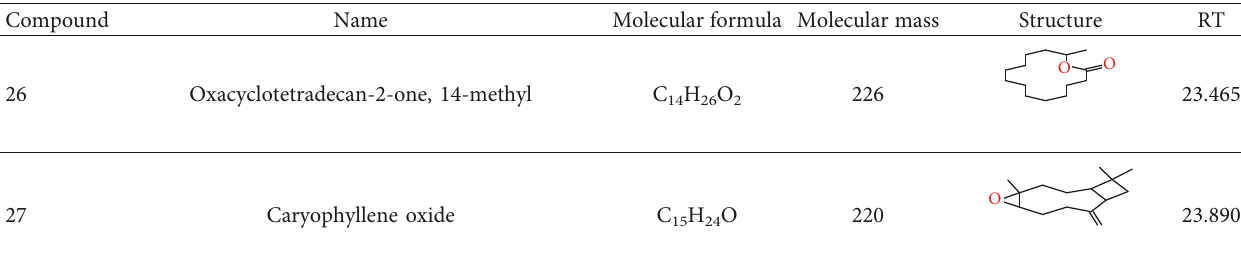
Table 7: Molecular formula, molecular mass, structure, and RTof compounds 26–30 of whole plant n -hexane fraction of Achillea wilhelmsii